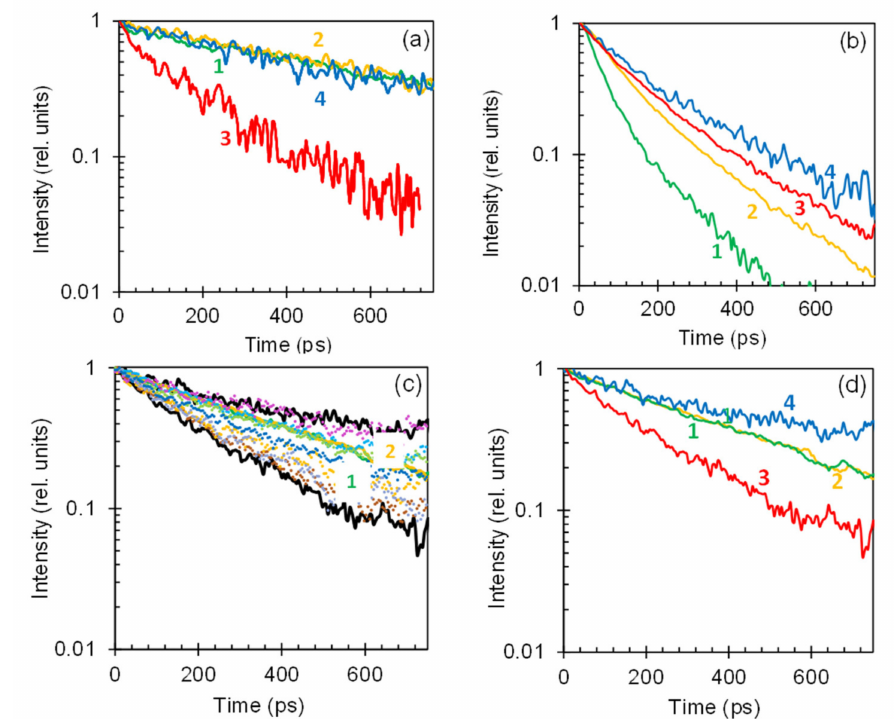
Figure 3. ( a ) Emission kinetics of HITC:PMMA at the low dye concentration equal to n = 3.2 g / L measured on top of glass (green trace 1), smooth thermally deposited Au film (yellow trace 2), and Au nanofoams: red trace 3 corresponds to the lower boundary of the emission kinetics spread, while the blue trace 4 corresponds to the upper boundary of the emission kinetics spread. ( b ) Same for the high dye concentration n = 36.5 g / L. ( c ) Emission kinetics of HITC:PMMA ( n = 12.7 g / L) recorded in di ff erent local spots of the dye-doped Au nanofoam samples. Traces 1 and 2 are the emission kinetics of the n = 12.7 g / L HITC dye on top of glass and smooth Au substrates, respectively. ( d ) Same as 3a and 3b at the dye concentration n = 12.7 g / L.